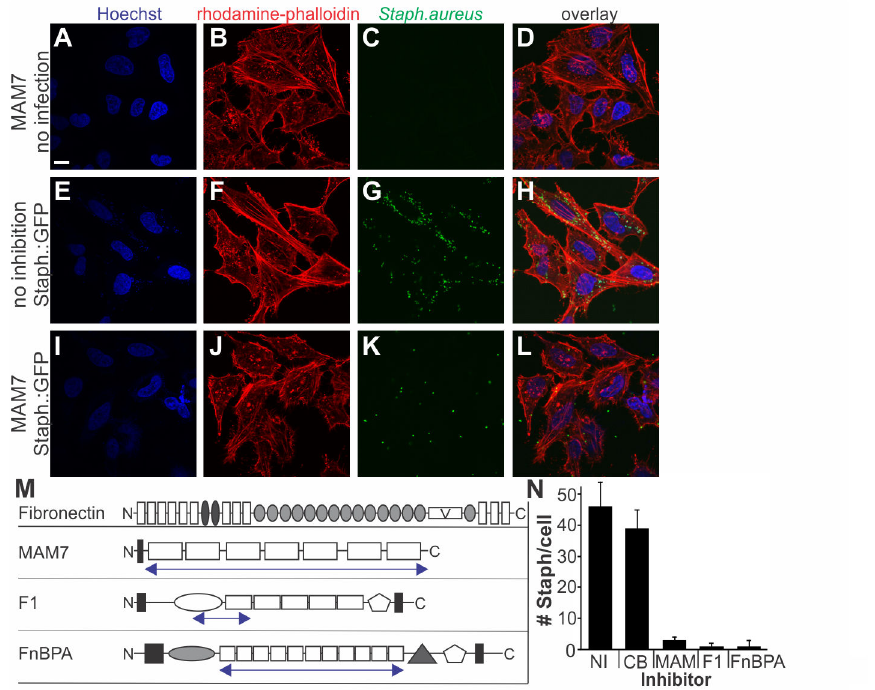
Figure 1. Adhesion inhibitors protect host cells from MRSA infection. GST or peptides derived from MAM7, F1 and FnBPA (blue arrows) were purified and immobilized on latex beads for inhibition experiments (M). HeLa cells incubated with MAM7-based inhibitor (A-D and I-L) and infected with S . aureus USA300:GFP (E-L). DNA (blue, A, E, L), F-actin (red, B, F, J) and S . aureus USA300:GFP (green, C, G, K) were visualized by fluorescence microscopy. Scale bar, 20 μm. S . aureus were counted after infection in the presence of no inhibitor, NI or immobilized GST, CB, MAM7, F1 or FnBPA-peptide inhibitors (N). Results are means ± standard deviation from analyzing 15 randomly chosen images per sample, from experiments done in